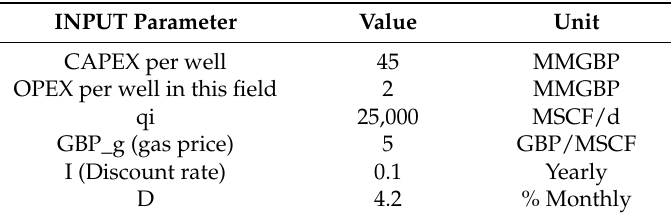
Table 3. Economical and forecasting assumptions.